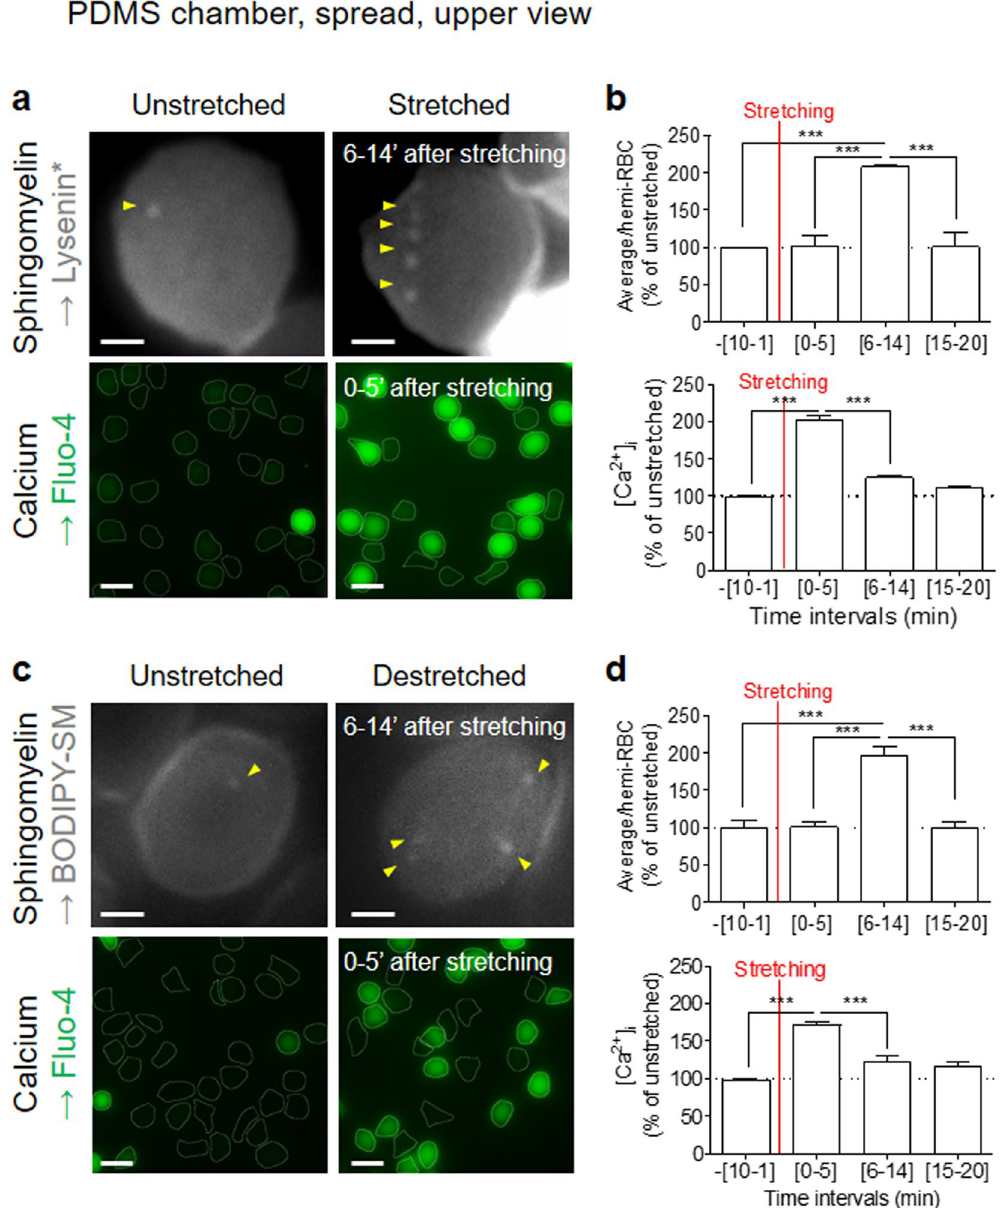
Figure 6. Transient increase of SM-enriched domains and calcium efflux during RBC shape restoration. Fresh healthy RBCs labelled for SM (Lysenin * /BODIPY-SM) or intracellular Ca 2 + (Fluo-4) and spread onto PLL- coated PDMS chambers were visualized before stretching ( unstretched ) and either after stretching ( stretched ; a,b ) or upon return to initial shape after a 1-min stretching ( destretched ; c,d ). ( a,c ) Representative imaging. In upper panels (SM labelling), one representative RBC is shown; y ellow arrowheads point to domains in LC membrane area. In lower panels (Ca 2 + labelling), several RBCs are shown. Representative imaging of 2–3 independent experiments, s cale bars 2 µ m in upper panels and 10 µ m in lower panels . ( b , d ) Quantification of domain abundance (number by hemi-RBC expressed as percentage of unstretched, upper panels ) and Fluo-4 intensity (average intensity by hemi-RBC expressed as percentage of unstretched, lower panels ). Results were grouped by time intervals around stretching time. Results are means ± SEM of 1459–1914 RBCs from 2–3 independent experiments. Statistical significance was tested with one-way ANOVA followed by Tukey’s post- hoc